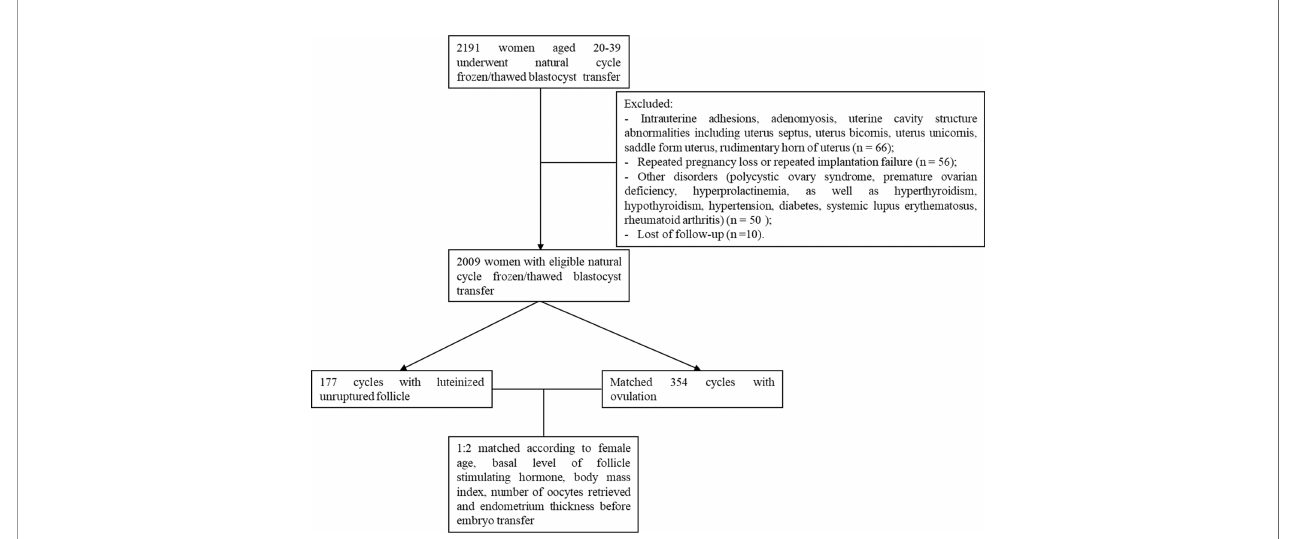
FIGURE 1 | Flowchart of the